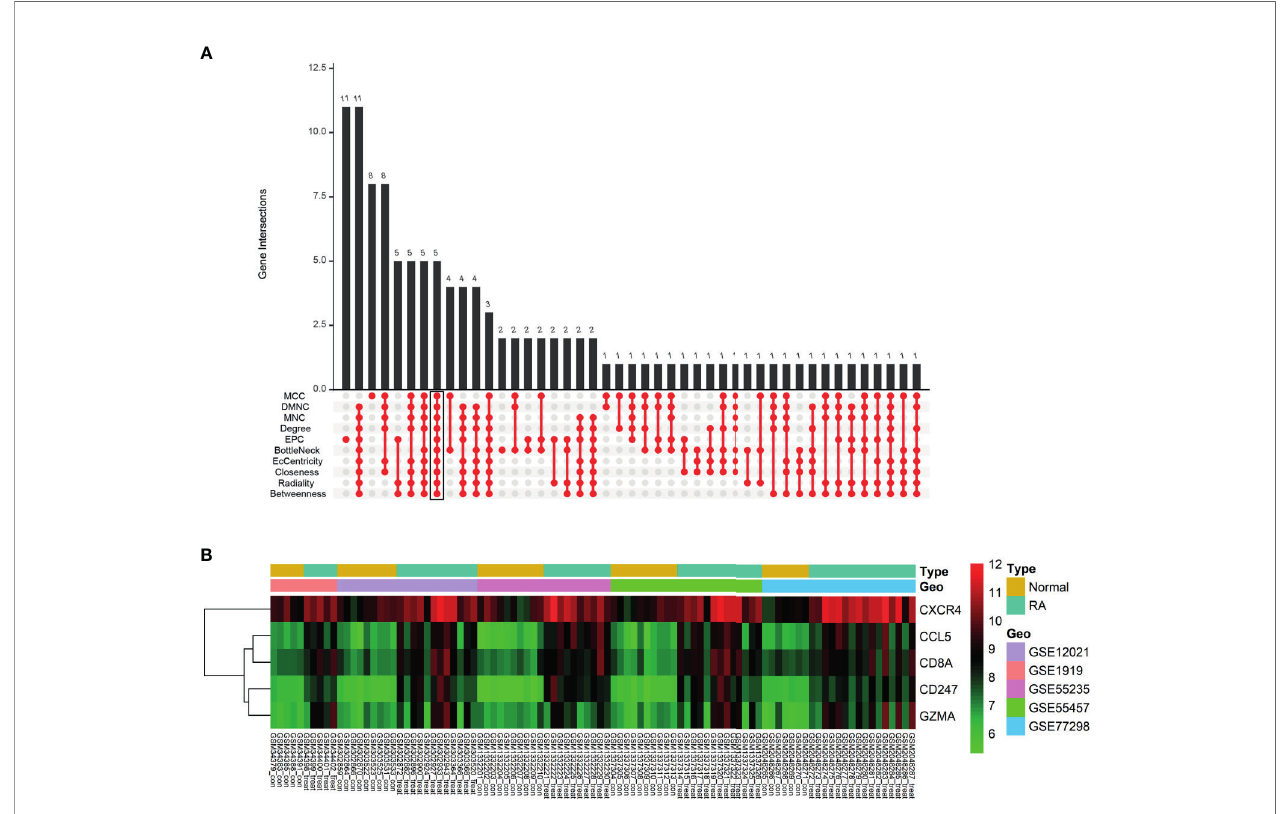
FIGURE 6 | Identi fi cation of hub genes. (A) Ten algorithms to screen hub genes by R package “ UpSet ” . (B) Expression of fi ve hub genes was presented by heatmap in merged microarray